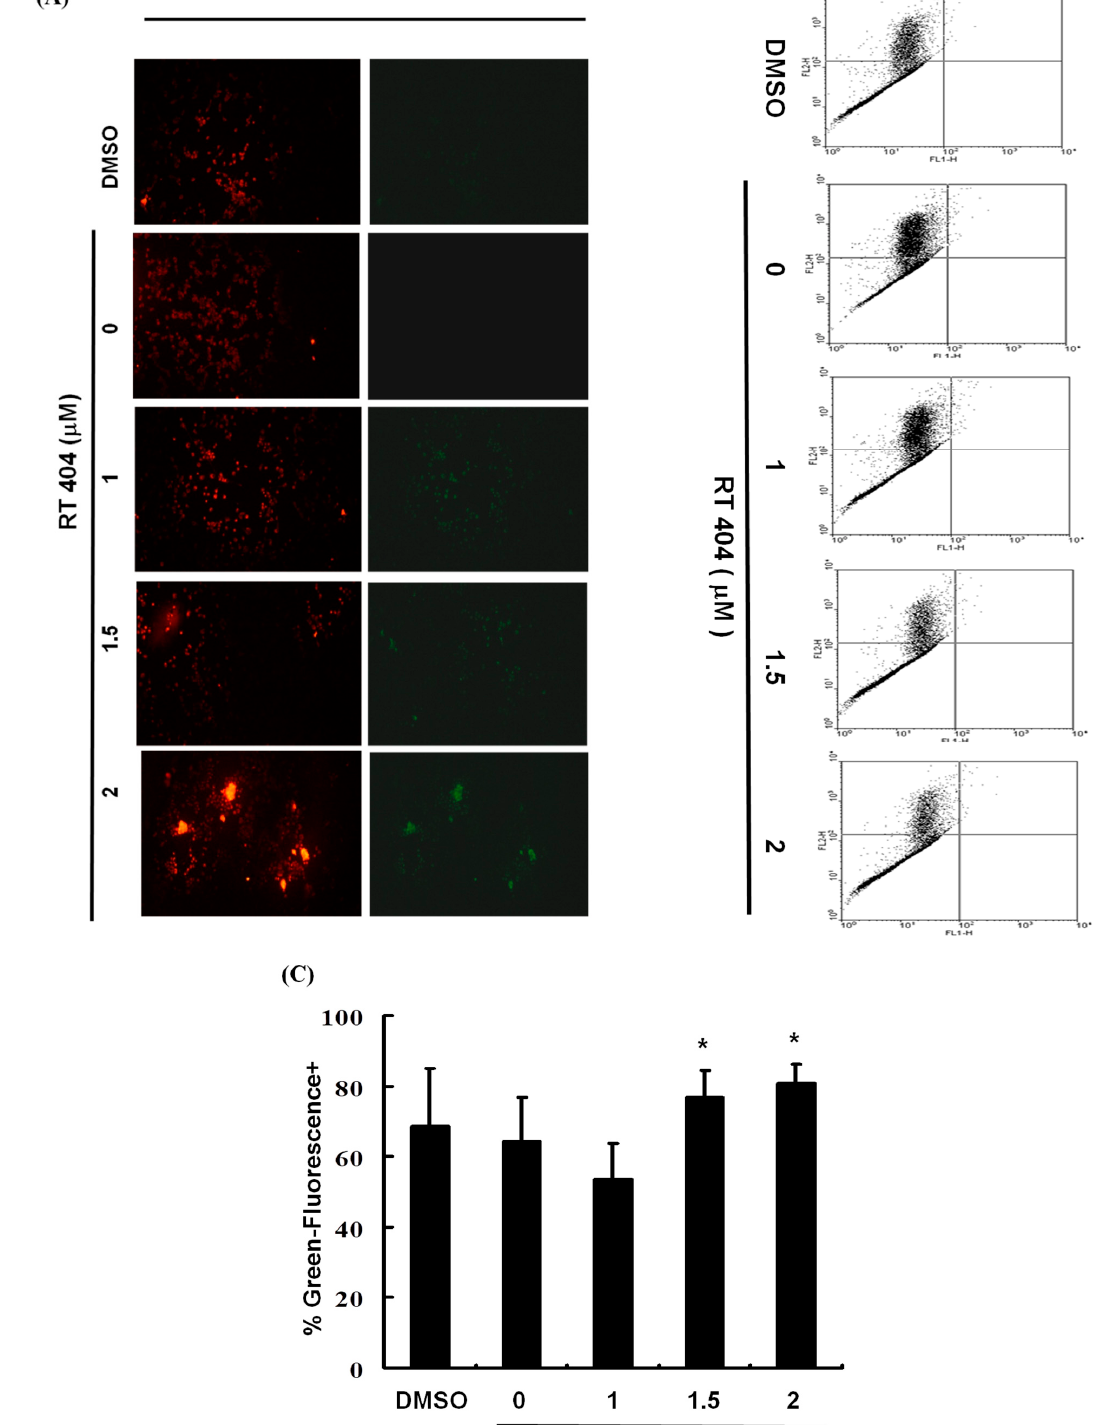
Figure 3. Disruption of the mitochondrial membrane potential caused by RTA404 treatment. JC-1 was also detected by using fluorescence microscopy ( A ) and flow cytometry ( B ). ( C ) Results are expressed as a percentage of the control, with the control being 100%. All data are reported as the means ± standard errors of the mean on the basis of the results of at least three separate experiments. Statistical analysis was performed using the t test, with differences between the treatment and control groups considered significant at p < 0.05, as denoted by *.